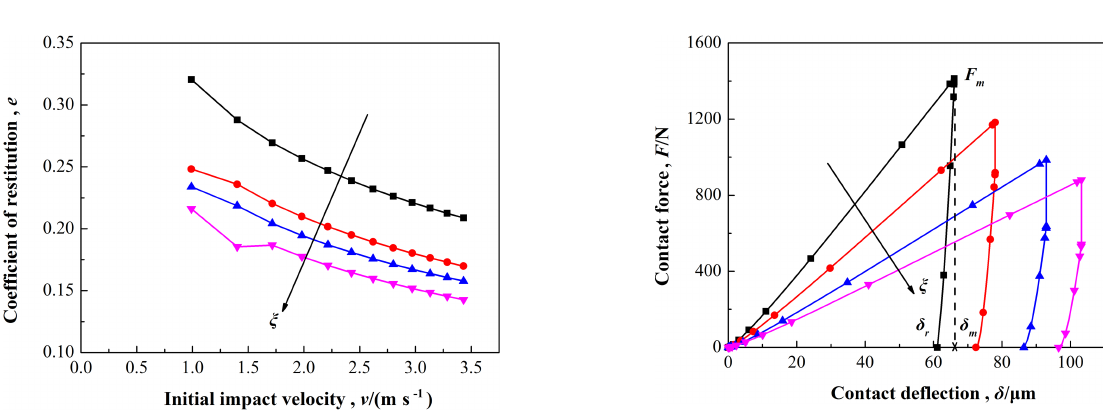
Figure 16. The coefficient of restitution as a function of initial im- pact velocity, and with ξ varied from 1 / 8 to 7 / 8.